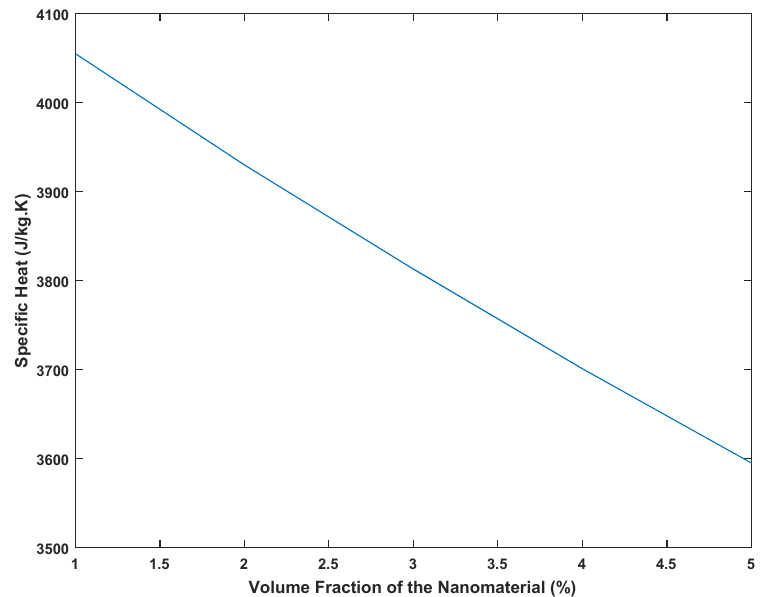
Volume Fraction of the Nanomaterial (%)